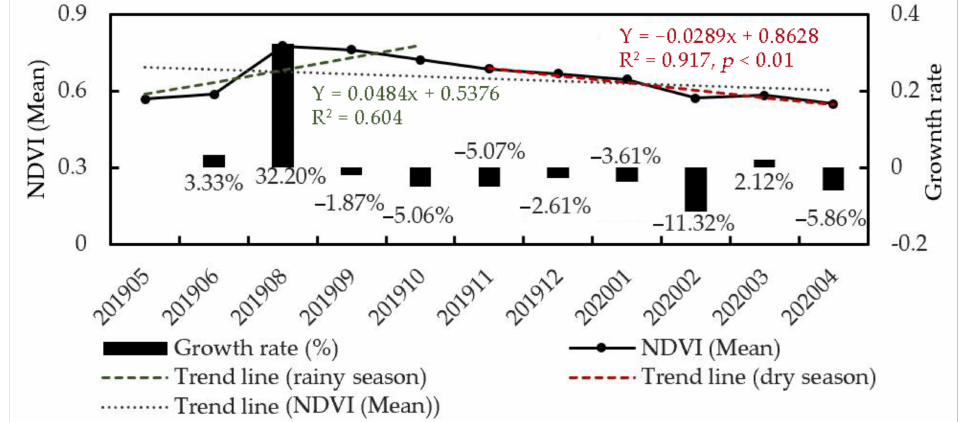
Figure 2. Variation in monthly NDVI averages from May 2019 to April